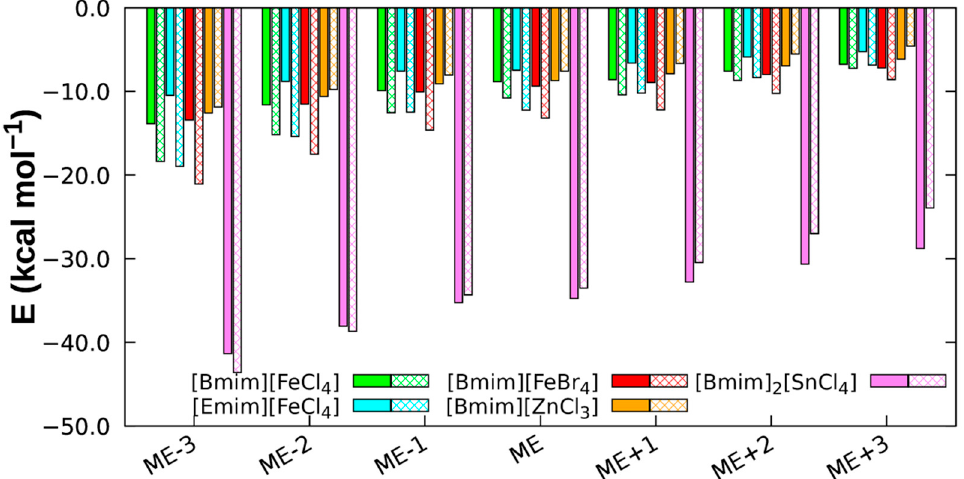
Figure 5. Induction (filled bar) and dispersion (line patterned bar) components obtained through SAPT0 for the MILs. ME is the most stable distance and the signs − or + correspond to a decrease or an increase of the distance between the CM, respectively.